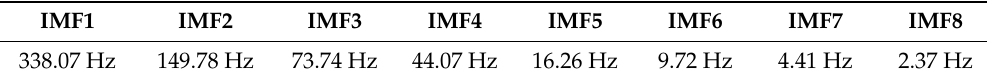
Table 6. The frequency distribution of IMFs by EEMD.